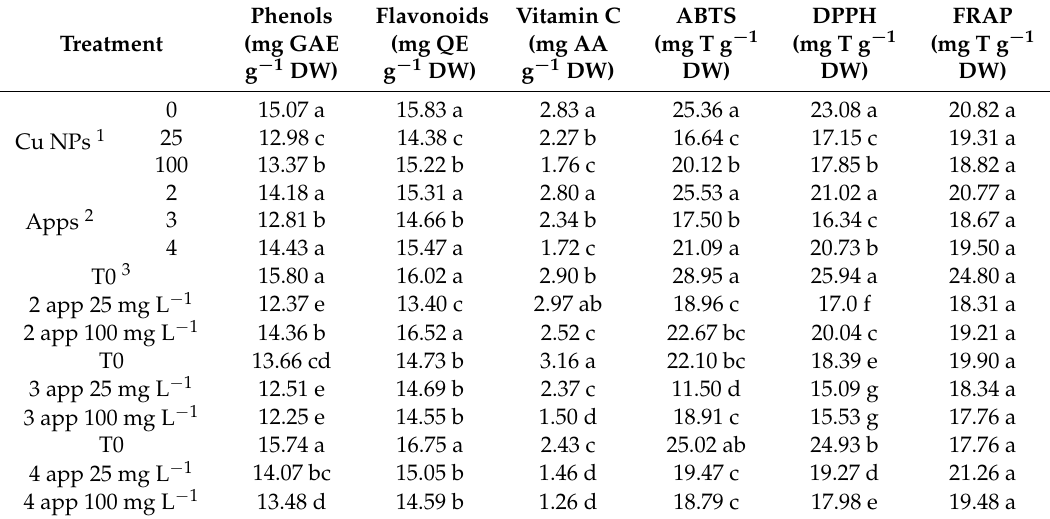
Table 3. Antioxidant content in fruits of Moringa oleifera